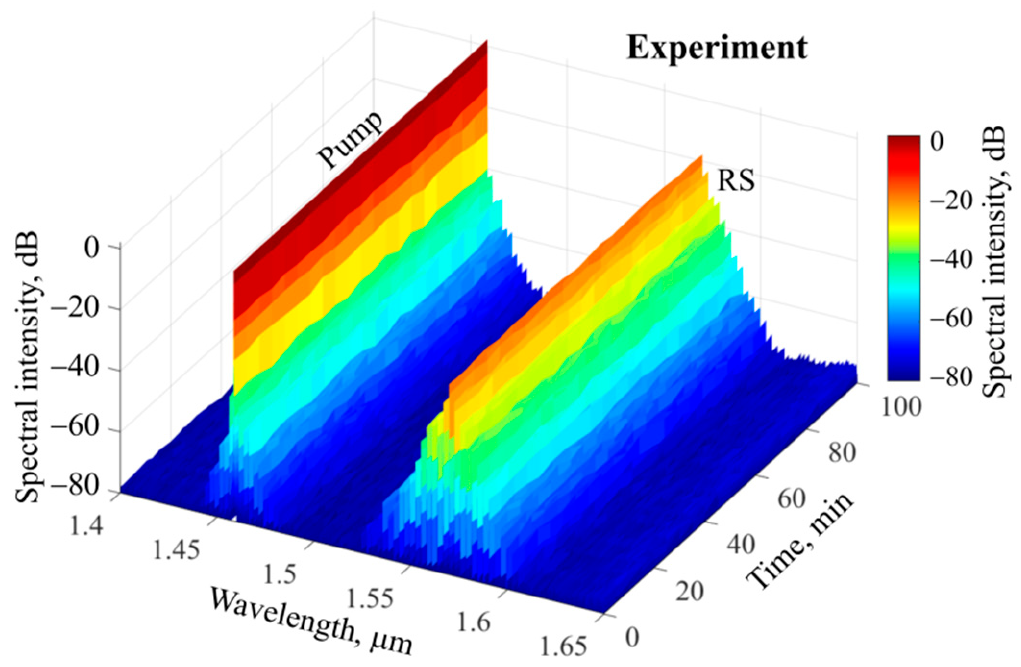
Figure 6. Stable spectra of optical frequency comb measured for 100 min. Experimental parameters